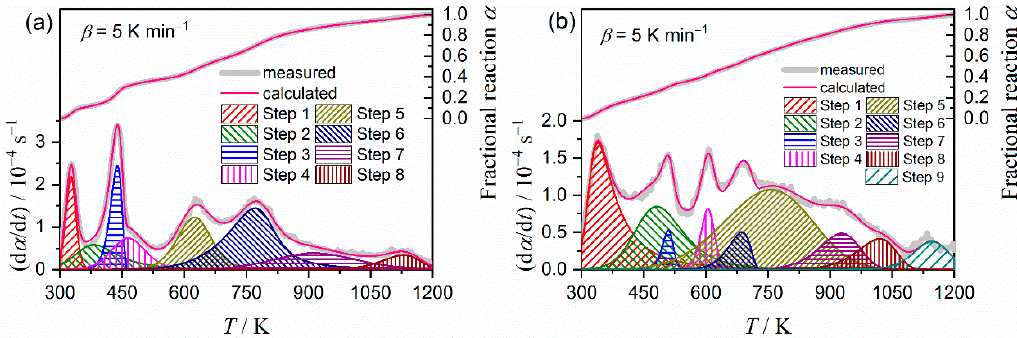
Figure 11. Typical results of KDA for the thermal decomposition of MB: ( a ) P-MB and ( b ) S-MB.